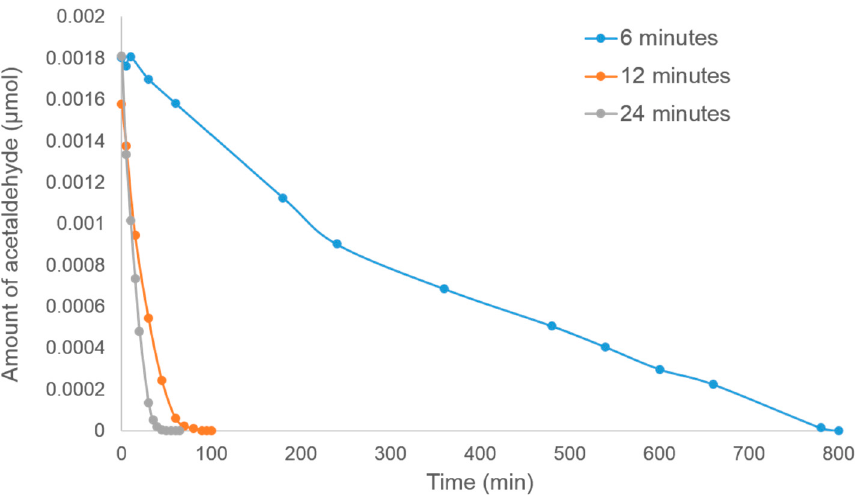
Figure 7. Photocatalytic decomposition of acetaldehyde by using TiO 2 on stainless steel prepared by Spray-ILGAR technique using different spraying durations (6, 12 and 24 min), 6.83 mM of TiO 2 precursor and heating temperature of 460 °C.